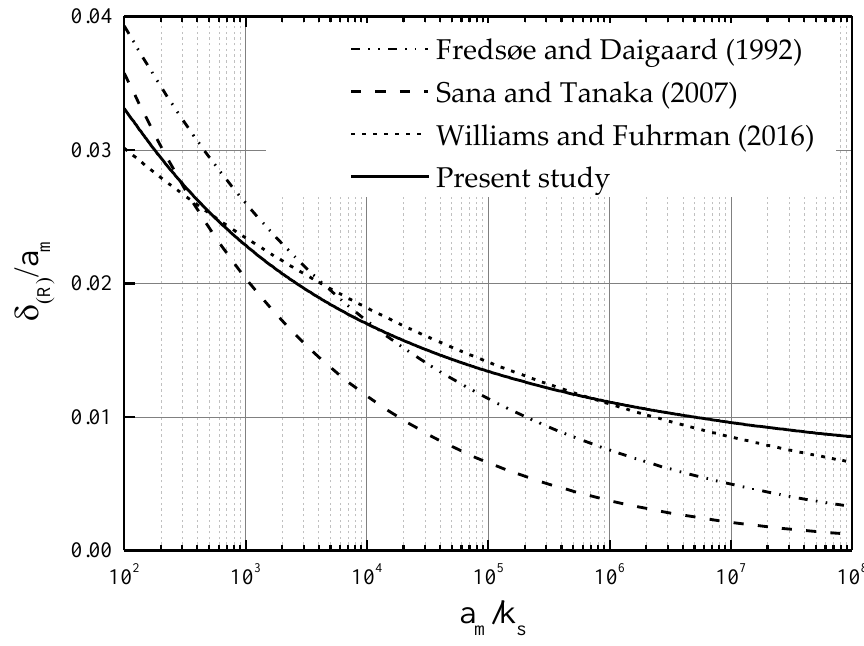
Figure 3. Comparison of calculation formulas for wave boundary layer thickness (rough turbulent).